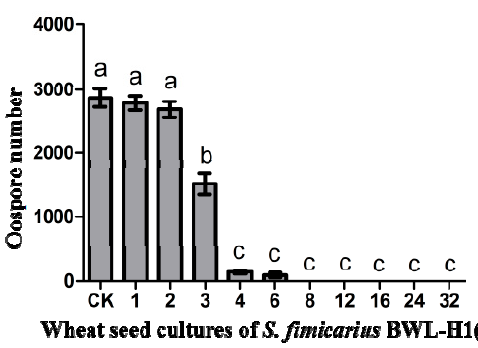
Figure 2. Suppression of P. litchii oospore production by S. fimicarius BWL-H1 volatiles. Barchart represents mean ± S.E. of oospores per cm 2 area from 10 mm around the inoculation site. Data represent three independent experiments with triplicates. Values followed by different letters were significantly different ( p < 0.05).